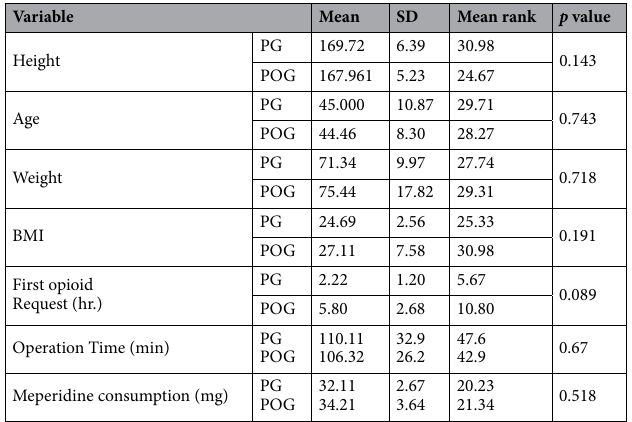
Table 1. Demographic characteristics and opioid request of the two group